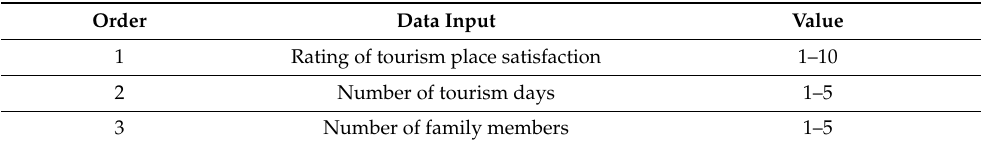
Table 1. Dataset input for